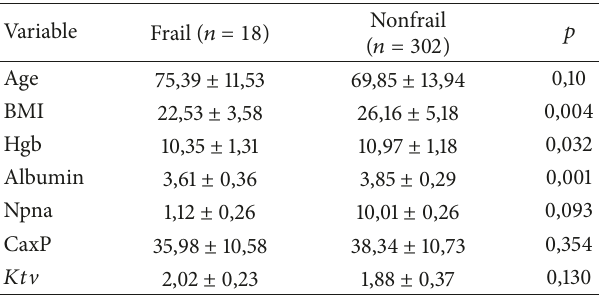
Table 2: Clinical and analytical characteristics of frail versus nonfrail